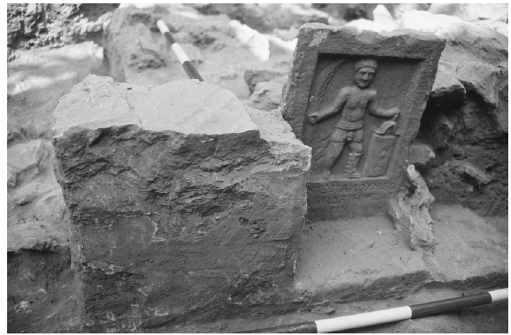
Figure 2. In situ gladiator tombstone excavated in the